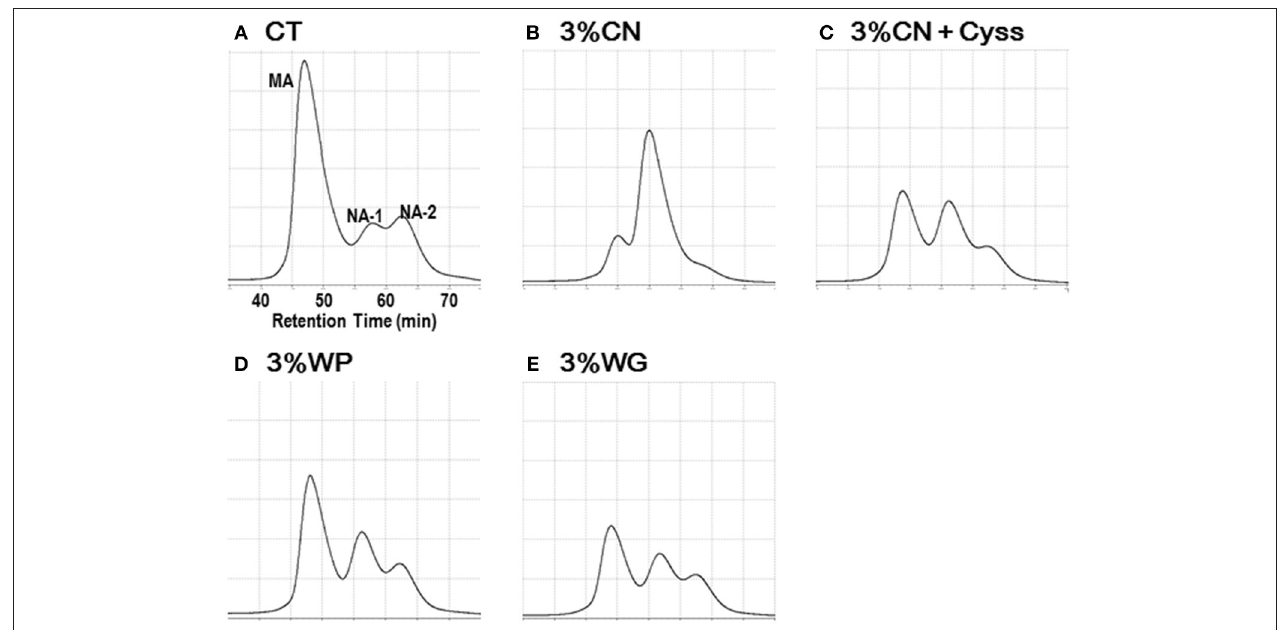
FIGURE 2 | Chromatograms of plasma albumin in Experiment 1. Plasma samples, obtained during the experimental period, were subjected to HPLC to determine albumin redox state. Typical chromatograms of the (A) control diet (CT diet), (B) 3% casein diet (3% CN diet), (C) 3% CN diet supplemented with cystine, (3% CN + Cyss diet), (D) 3% whey protein diet (3% WP diet), and (E) 3% wheat gluten diet (3% WG diet) groups, at week 4 are shown. MA and NA denote mercaptalbumin and non-mercaptalbumin, respectively.